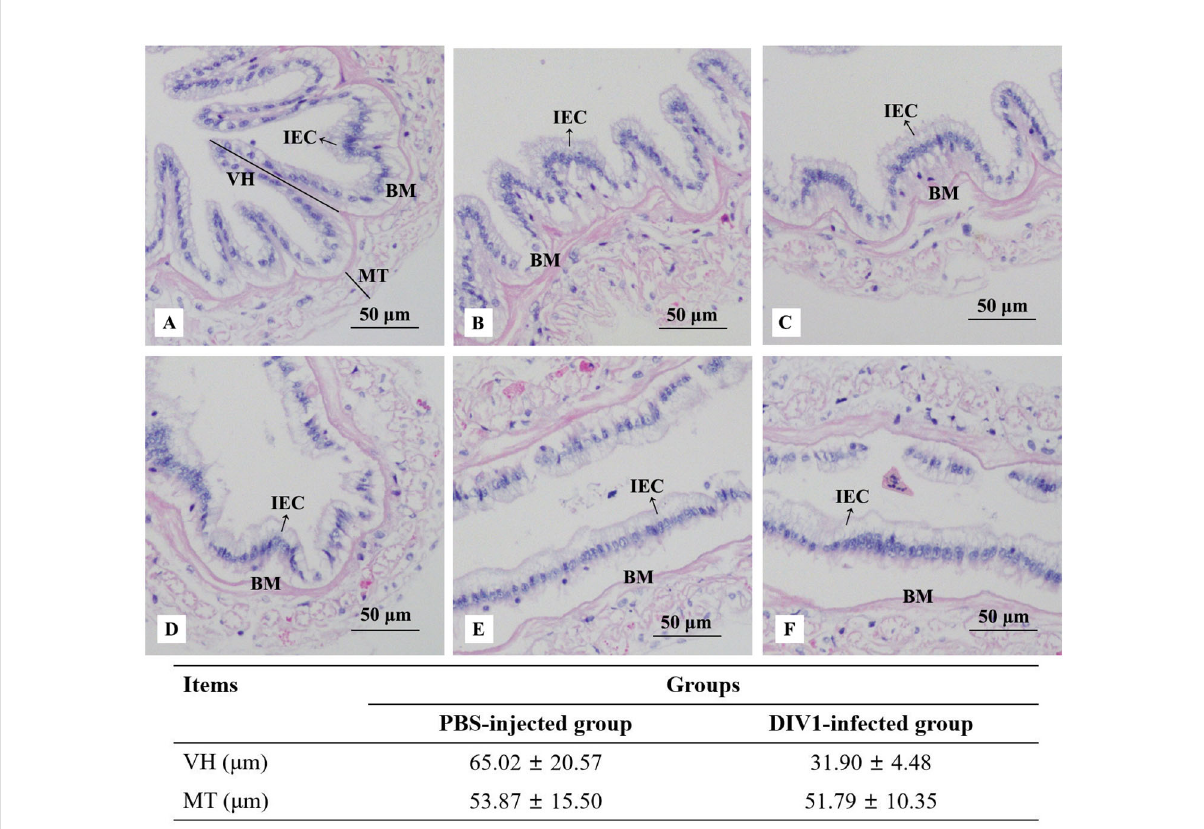
FIGURE 1 Photomicrographs of intestinal sections in the PBS-injected group (A-C) and the DIV1-infected group (D-F) . IEC, intestinal epithelial cells; BM, basement membrane; VH, villus height; MT, muscle